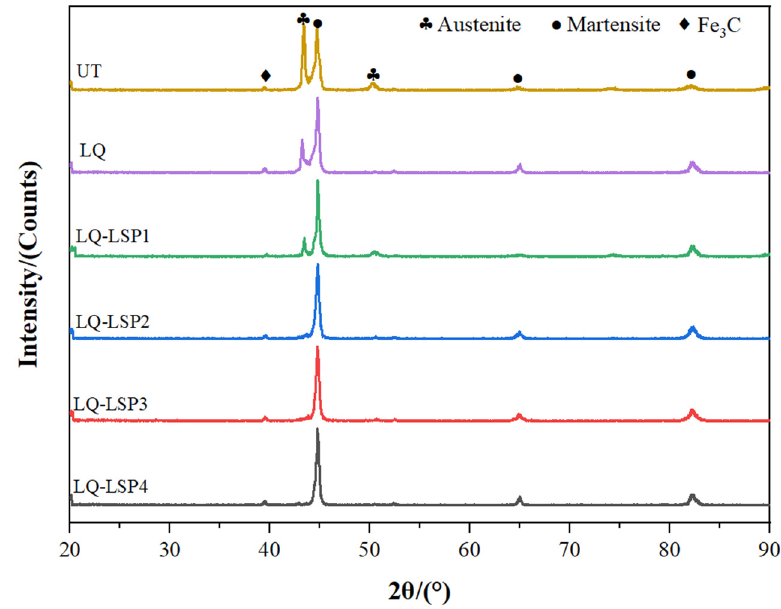
Figure 6. XRD patterns of samples treated by different processes.